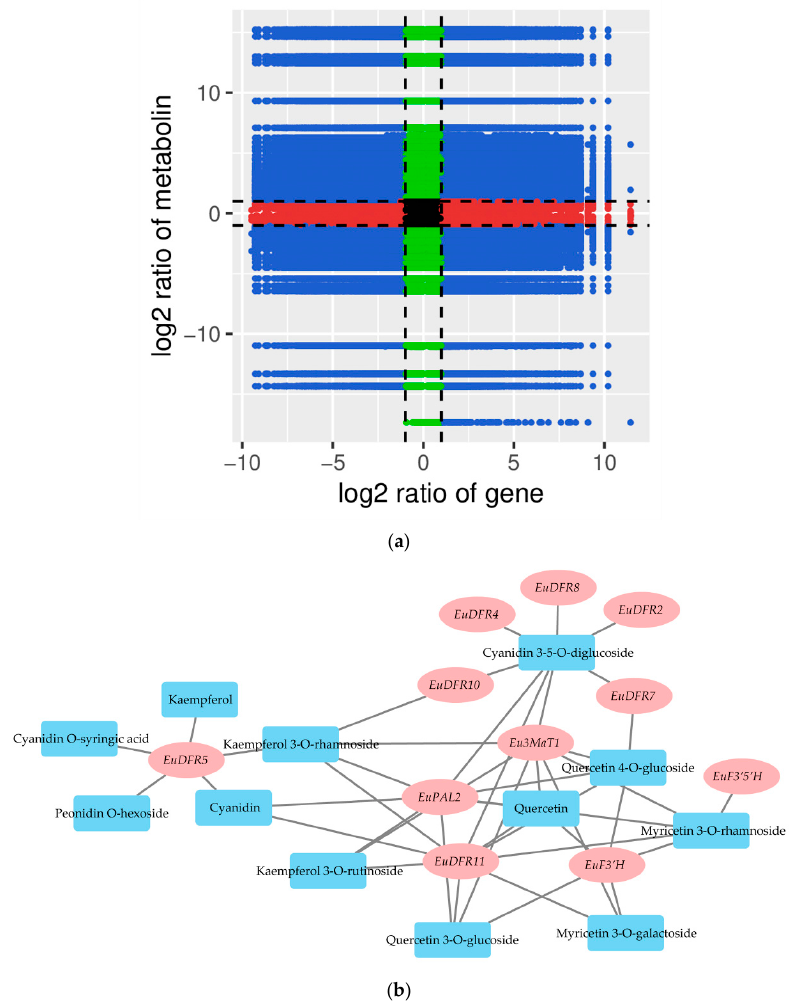
Figure 7. Integrative analysis of the metabolome and transcriptome . ( a ) Quadrant diagrams representing the association of metabolomic and transcriptomic data. ( b ) Co-expression network of metabolites and genes involved in flavonol and anthocyanin biosynthesis. The gene–metabolite pairs were connected within the network by edges. Red nodes represent genes, and blue nodes represent metabolites.